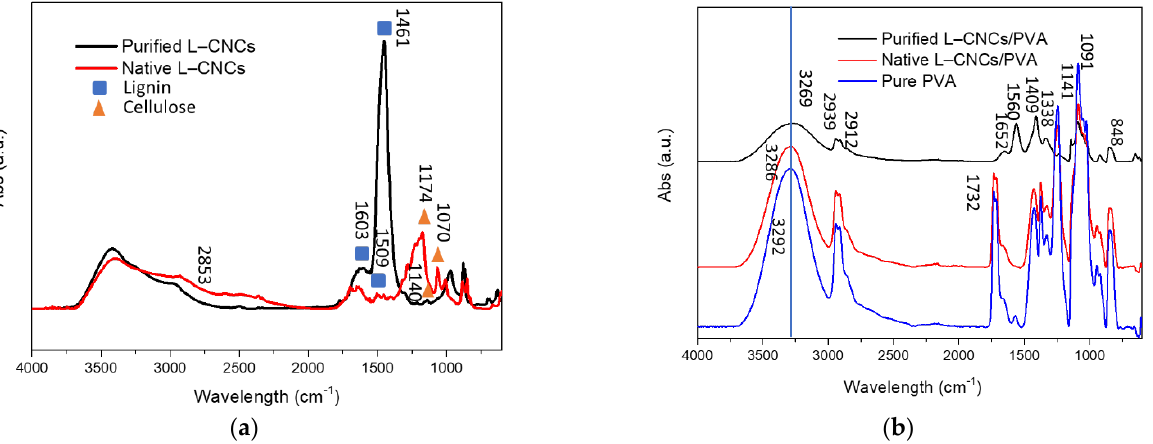
Figure 4. FTIR spectra of ( a ) purified L – CNCs and native L – CNCs, ( b ) purified L – CNCs/PVA, native L – CNCs/PVA and pure PVA.